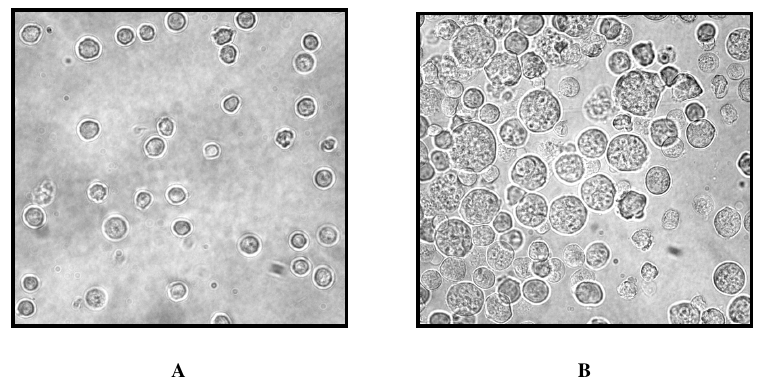
FIGURE 5. Appearance of double-fluorescent cells after sorting of (A) FRET-negative and (B) FRET-positive particles. Magnification 400 × . (Reprinted from Huerta et al.[87]. Copyright 2006, with permission from Elsevier.)